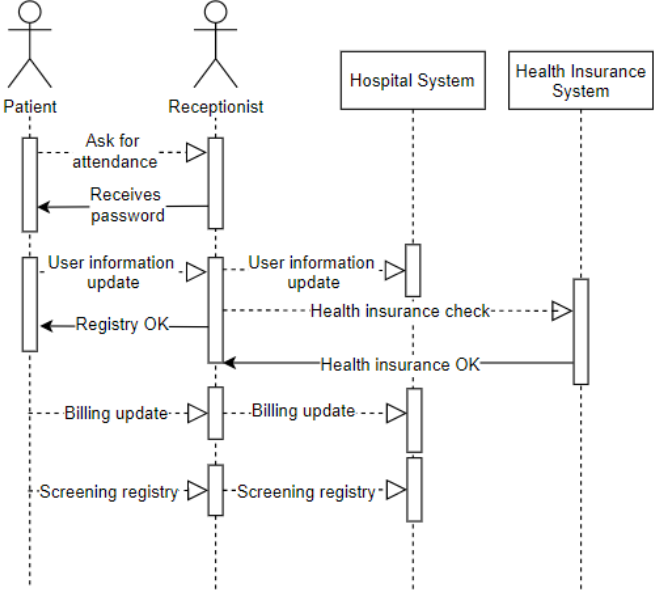
Figure 6. Sequence—Reception at the Emergency